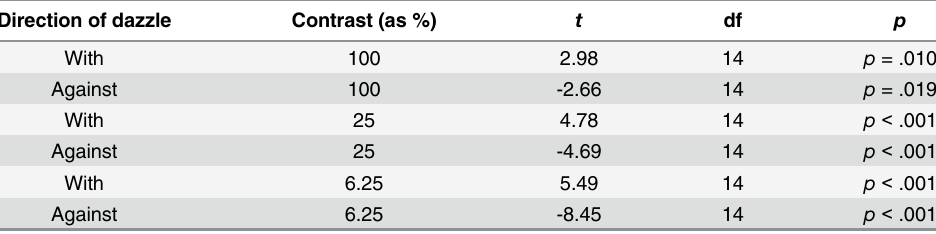
Table 4. One-sample t -test results for differences between dynamic dazzle and static dazzle control for each of the 3 contrast levels tested. Direction of dazzle Contrast (as %) t df p With 100 2.98 14 p = .010 Against 100 -2.66 14 p = .019 With 25 4.78 14 p < .001 Against 25 -4.69 14 p < .001 With 6.25 5.49 p < .001 Against 6.25 -8.45 p < .001 Statistics from one-sample t -tests (compared to 0)